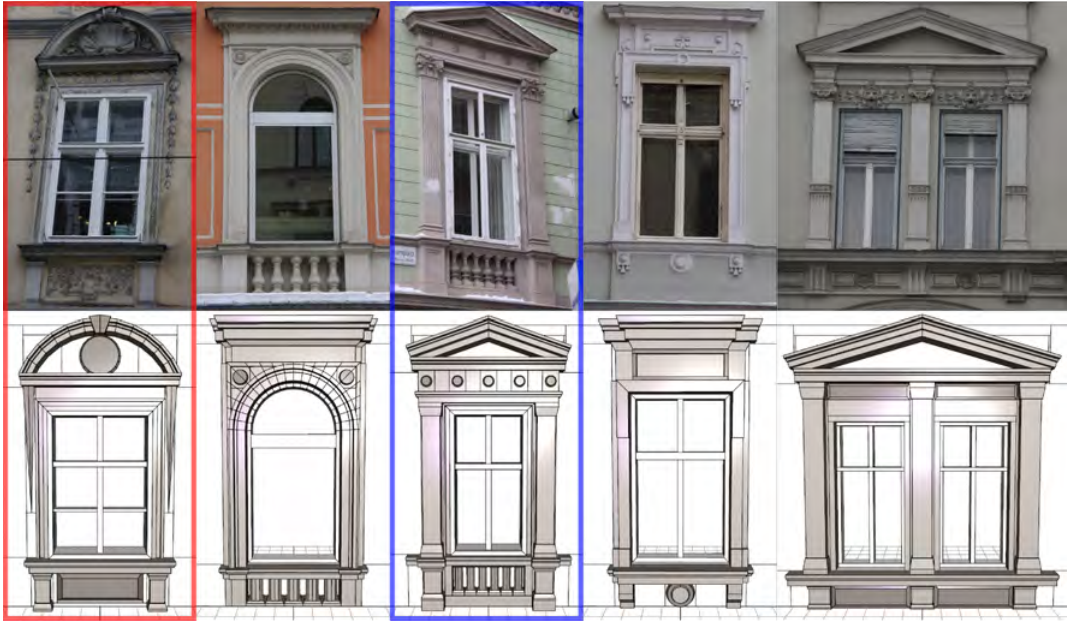
Figure 8: Synthesis of example windows. The first exercise was to reconstruct five window exemplars with sufficiently different layouts and decorations. The second task was the variation of the two windows in the red and blue frames (see Figure 9).